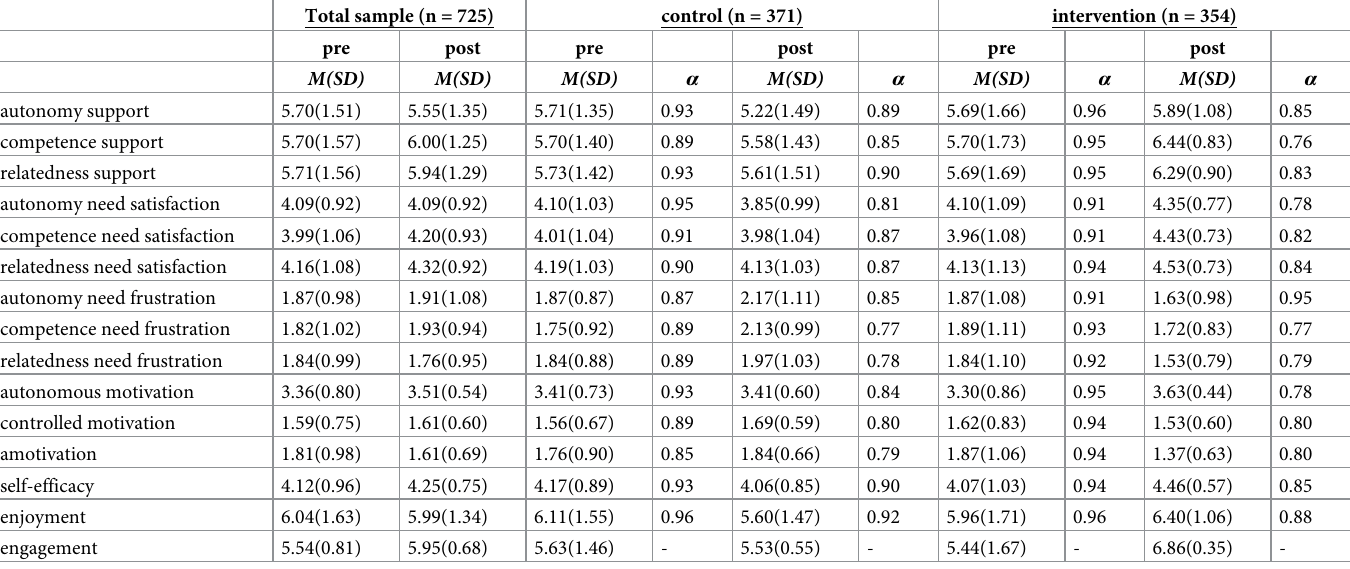
Table 1. Descriptive statistics and internal reliability coefficients of the variables in pre-test and